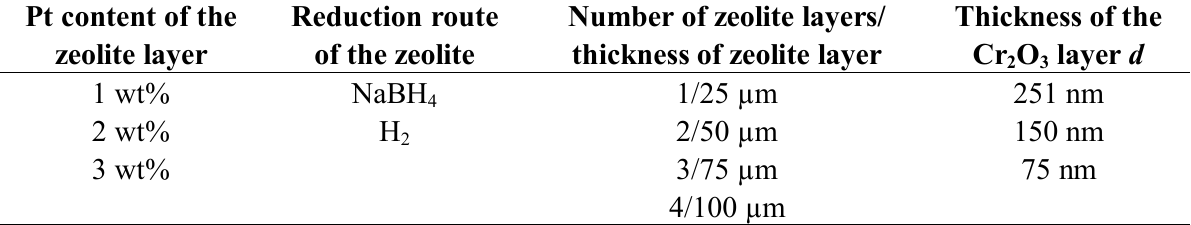
Table 2. Variation of sensor components.